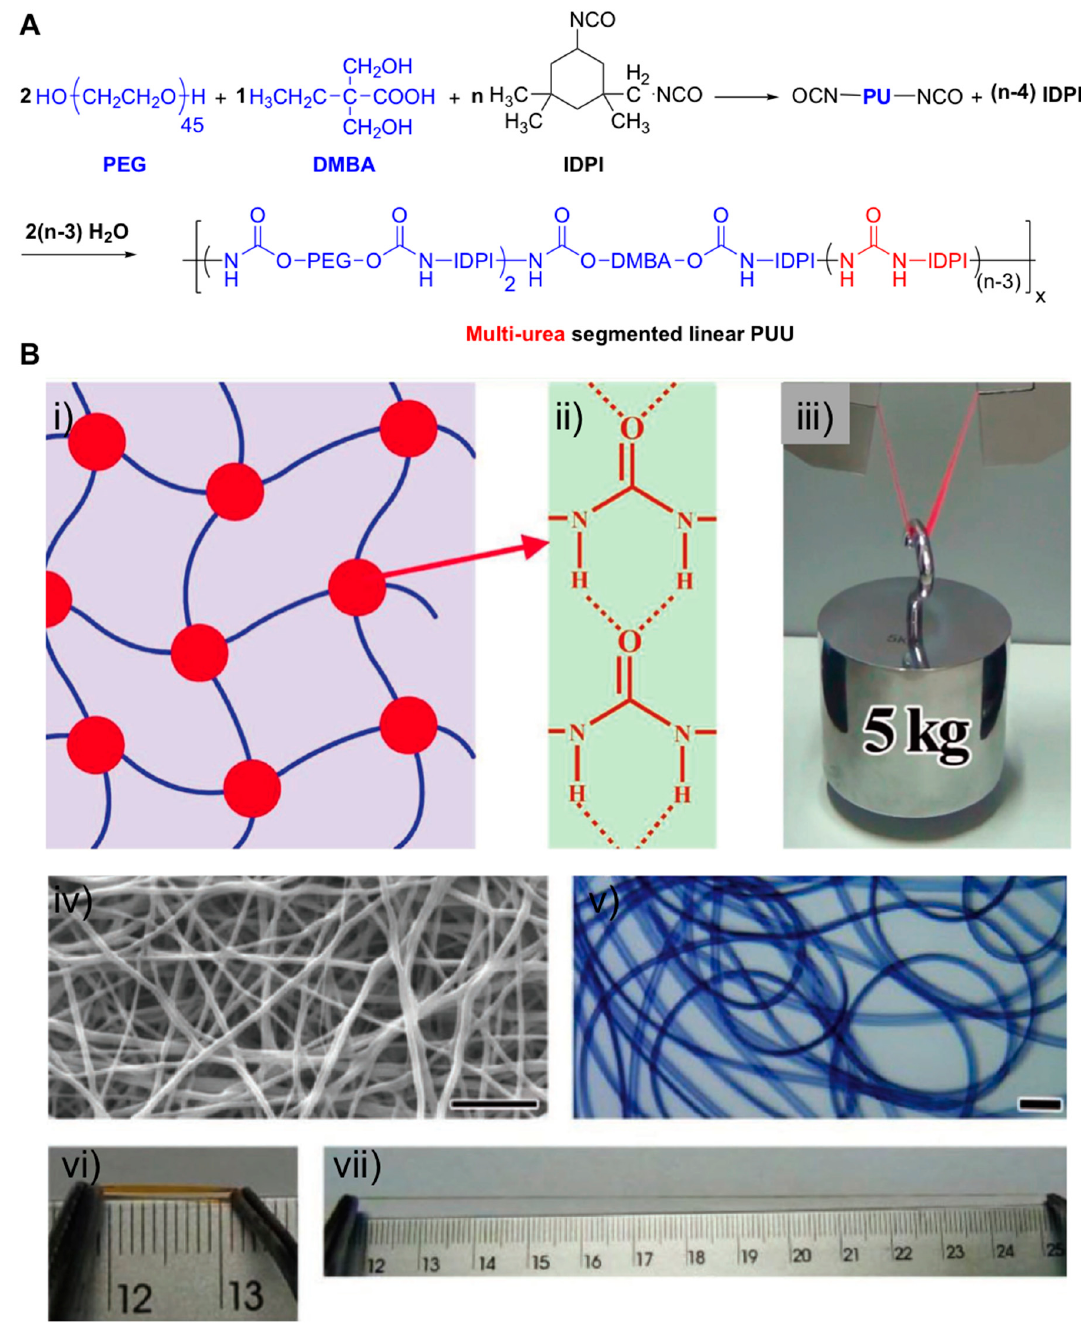
Figure 9. ( A ) Synthetic procedure of the multi-urea linkage segmented PUU copolymers. The obtained PUU copolymers in this work were named as PUU3- n , where n denotes the amount of IPDI used. ( B ) ( i , ii ) Illustrative depiction of the strong and stable H-bonding nanodomain cross-linked hydrogel network stemming from the aggregation of the hydrophobic multi-urea linkages. ( iii ) Photo image demonstrating ultra-strong and tough properties of the fully swollen hydrogel film with width of 10 mm and thickness of 1.0 mm. The film was dyed with Rhodamine B for easy observation. ( iv ) Scanning electron microscopy (SEM) image of the electrospinning PUU3-12 fibrous film from its DMF solution, 10 μ m scale bar. ( v ) Microscopic image of the microfluidic-spinning PUU3-12-based hydrogel microfibers from its DMF solution, 100 μ m scale bar. ( vi , vii ) The respective photo images of the original and stretched PUU3-12 hydrogel fiber. Adapted with permission from Reference [62]. Copyright 2017